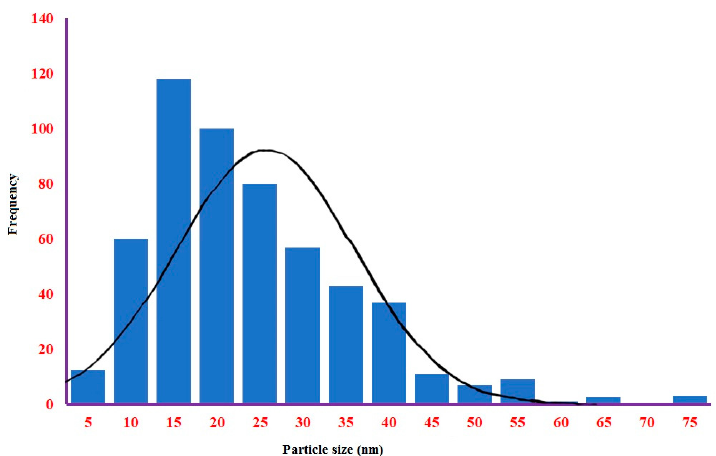
Figure 8. Number-frequency histogram of Fe 3 O 4 nanoparticles in GO/Fe 3 O 4 / L -pro hybrid.